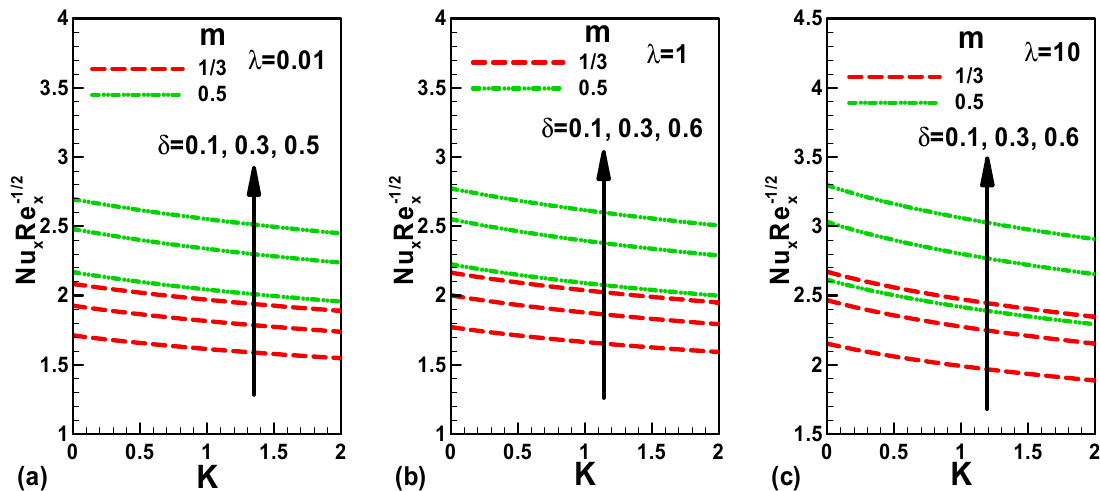
Figure 10. Variation of Nusselt number with pressure gradient and slip parameters for ( a ) forced convection, ( b ) mixed convection, and ( c ) free convection. [ n =0.5, Ω = π /6, Rd = 0.5, Da =100].